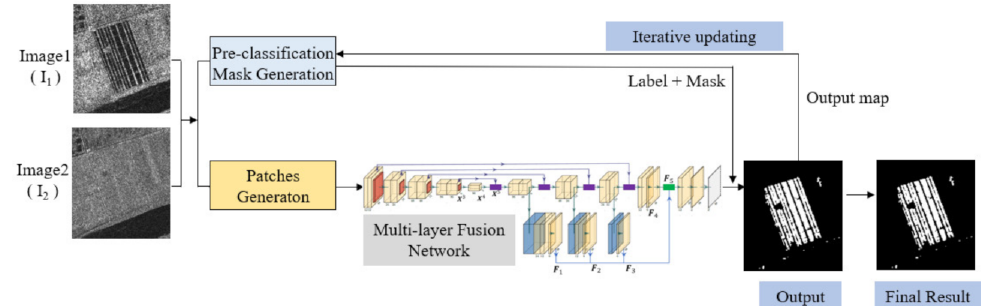
Figure 1. Overall workflow of the proposed network. Training samples and the designed mask are first generated from bi-temporal images. With the existence of a mask, the network based on UNet can learn in an end-to-end way, ignoring the irregular shape of labels. Through iteratively learning, the newly generated change map is further processed to obtain new label and mask, which will be used in the next learning iteration.